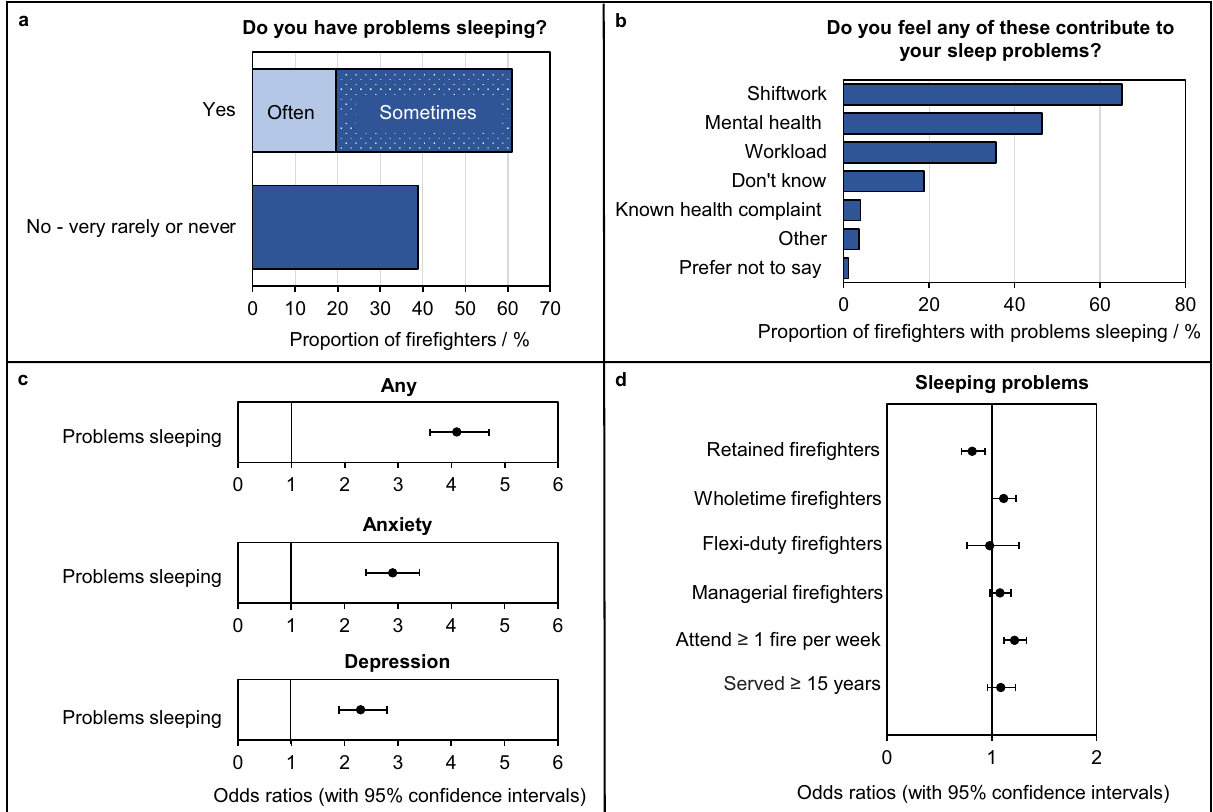
Figure 4. Firefighters’ Sleeping Problems. ( a ) The proportion of total surveyed firefighters who indicated whether they had sleeping problems. ( b ) The proportion of firefighters with sleeping problems listing the reasons for their sleep disturbances. Note that firefighters were able to select more than one reason. ( c ) Adjusted odds ratios (with 95% confidence intervals) for firefighters’ mental health conditions due to sleeping problems. ( d ) Adjusted odds ratios (with 95% confidence intervals) for firefighters sleeping problems due to demographic variables. Note that odds ratios presented in ( c ) and ( d ) were adjusted for a variety of disturbed sleep risk factors (Supplementary File S2).